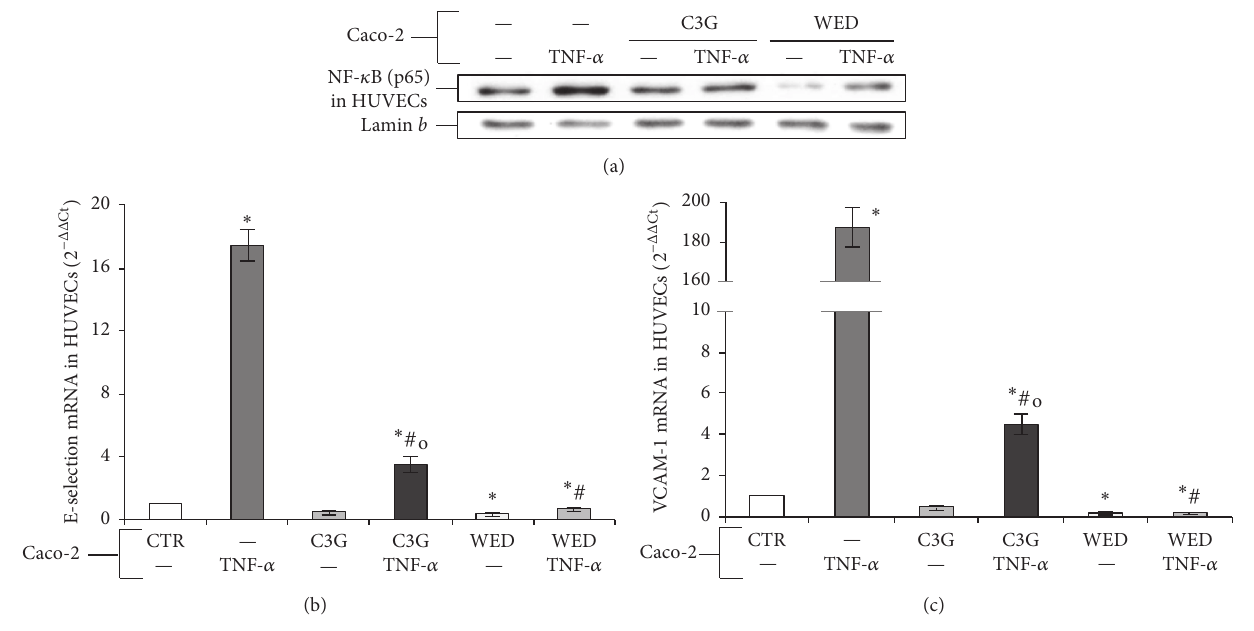
Figure 4: (a) Nuclear NF- 𝜅 B (p65) localization and gene expression of E-selectin (b) and VCAM-1 (c) in HUVECs. HUVECs were cocultured for 4 hours with Caco-2 cell monolayers previously pretreated for 24 hours with 20 𝜇 M C3G or with 25 𝜇 M WED for one hour and subsequently exposed to 50 ng/mL TNF- 𝛼 for one hour. Cultures treated with Caco-2 cells exposed to the vehicle alone (0.1% DMSO) were used as controls (CTR). (a) HUVEC nuclear lysates were analyzed by western blot, and nuclear localization of the p65 protein was evaluated. (b-c) HUVEC E-selectin and VCAM-1 RNA were analyzed by RT-PCR and data are expressed as 2 −ΔΔ Ct ; GAPDH was used as housekeeping gene. Results, deriving from three independent experiments, are reported as mean ± SD. ∗ 𝑝 < 0.01 versus CTR; # 𝑝 < 0.01 versus TNF- 𝛼 ; o 𝑝 < 0.01 versus